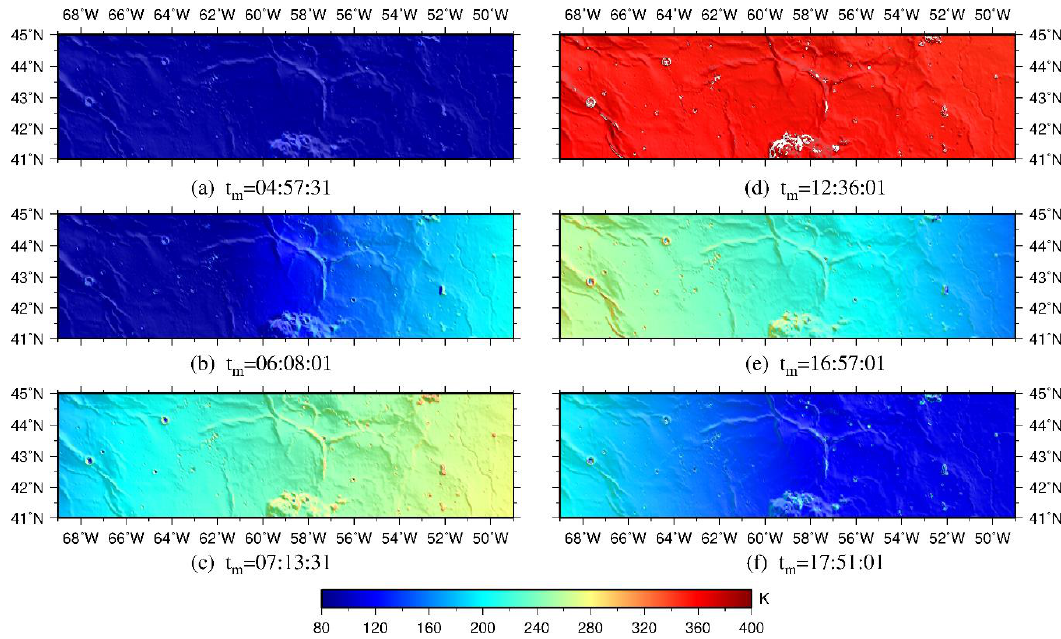
Figure 6. Surface temperature variation with different time. ( a ) Universal Time Coordinated